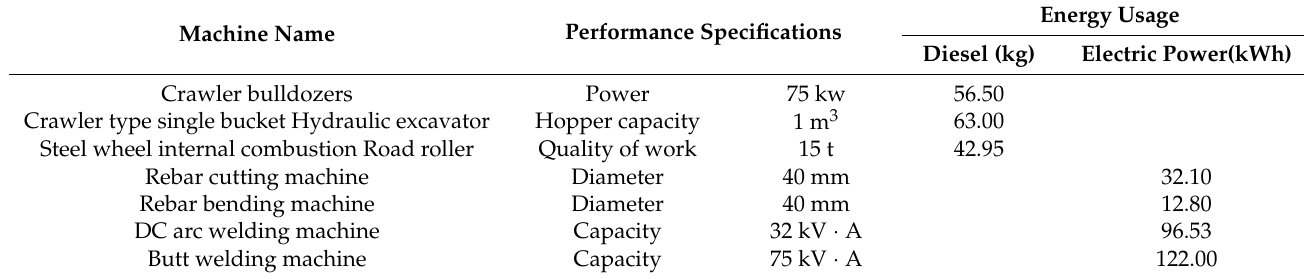
Table 2. Energy consumption of construction machinery shift.